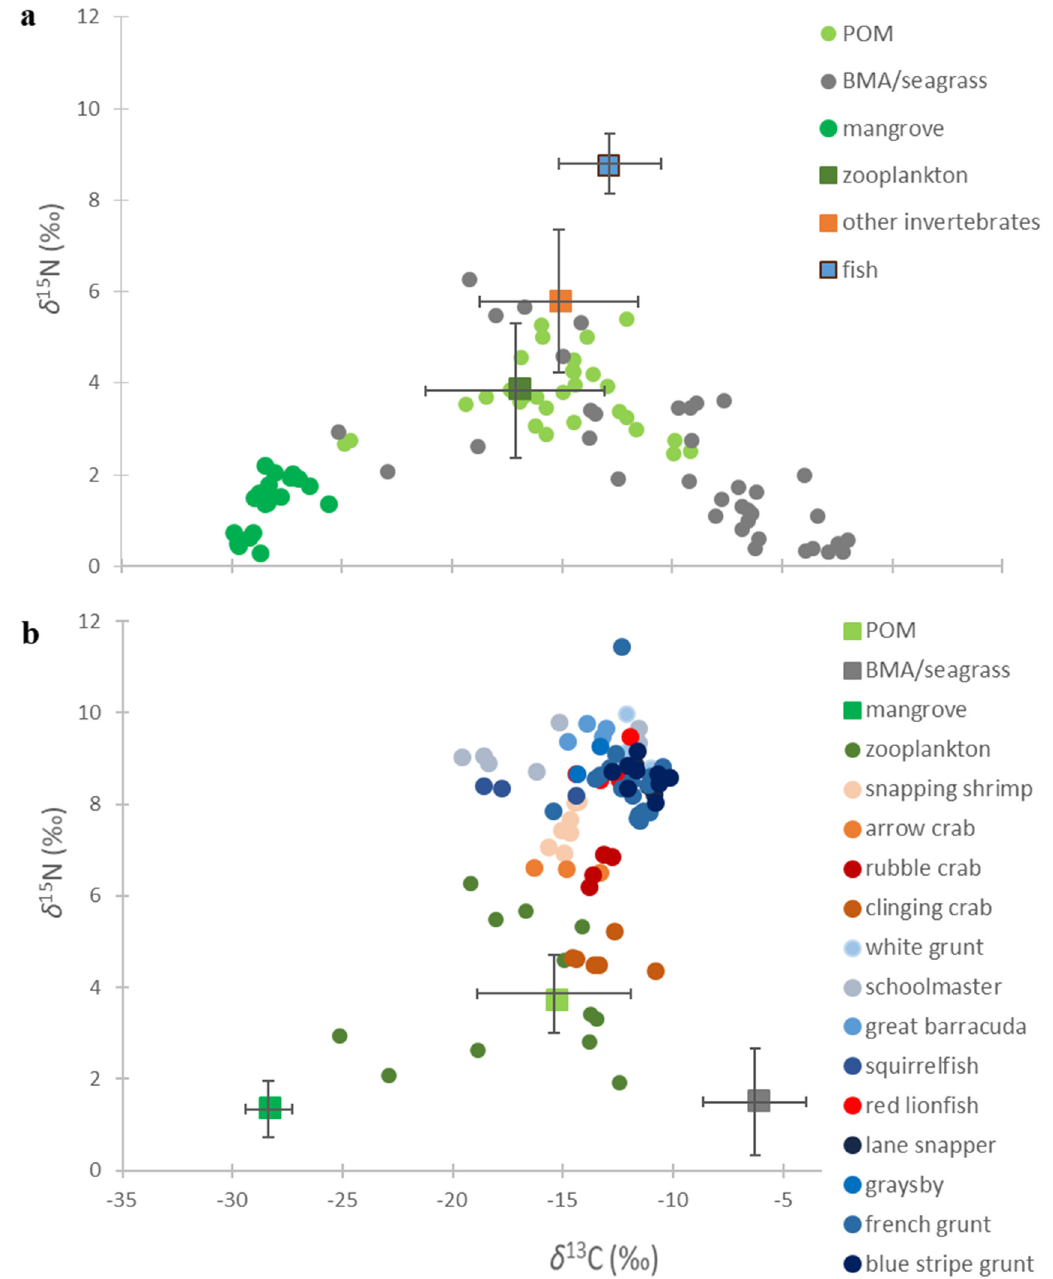
Figure 4. ( a ) Isotope biplot displaying individual δ 13 C and δ 15 N values for the POM, BMA/seagrass and red mangrove (circles) and the mean (±SD) δ 13 C and δ 15 N values for zooplankton, other invertebrates and fish (squares), and ( b ) Isotope biplot displaying individual δ 13 C and δ 15 N values for the benthic invertebrates and fish species (circles) and the mean (±SD) δ 13 C and δ 15 N values for POM, BMA/seagrass and red mangrove (squares).